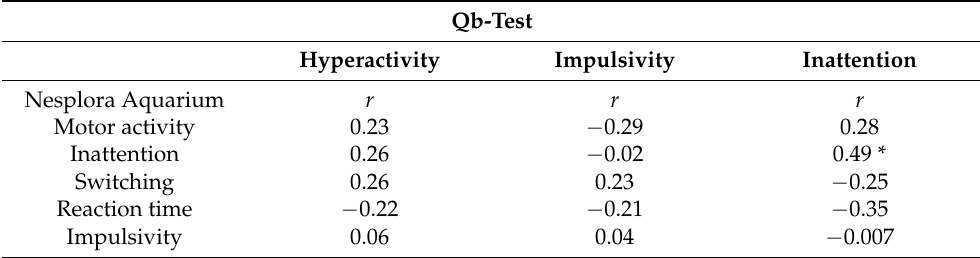
Table 3. Correlations between the principal components of Nesplora Aquarium and the